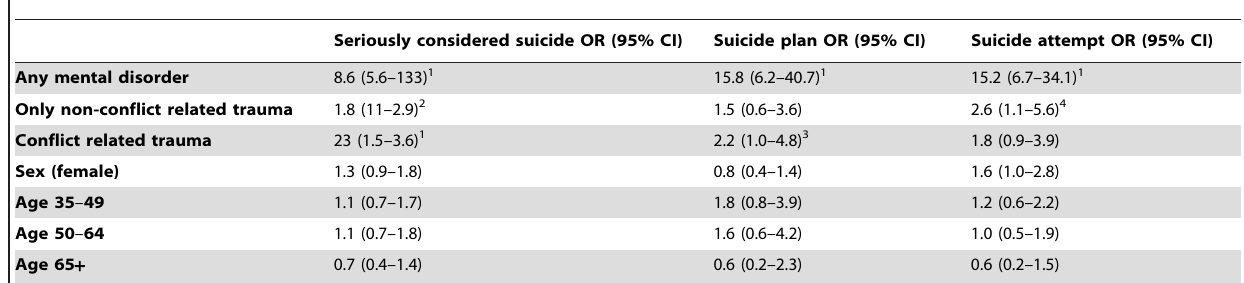
Table 4. Logistic regression analyses of socio-demographic and conflict related trauma correlates of suicidal ideation, plans and